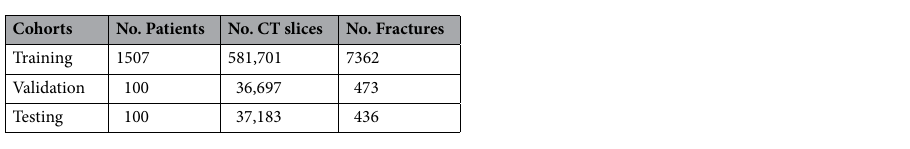
Table 1. The overview of